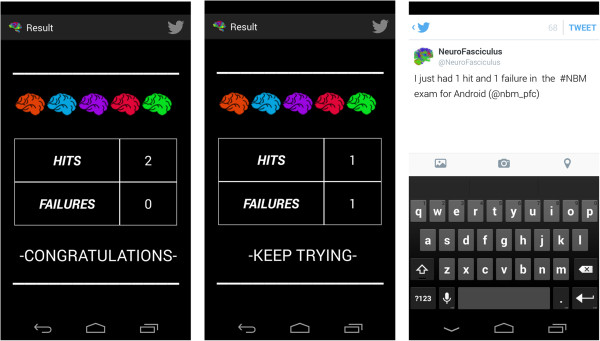
Examination Results.